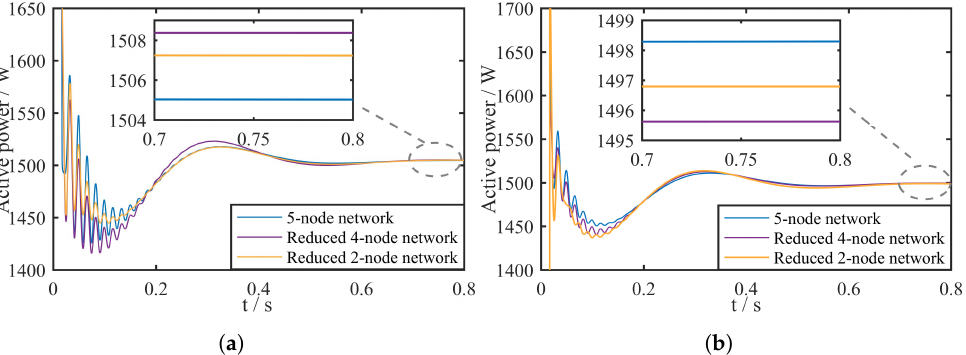
Figure 11. Output active power in the process of simplification of the generator node 4 in ( a ) and 5 in ( b ). Table 3. The power flow data of preserved nodes after every reduction